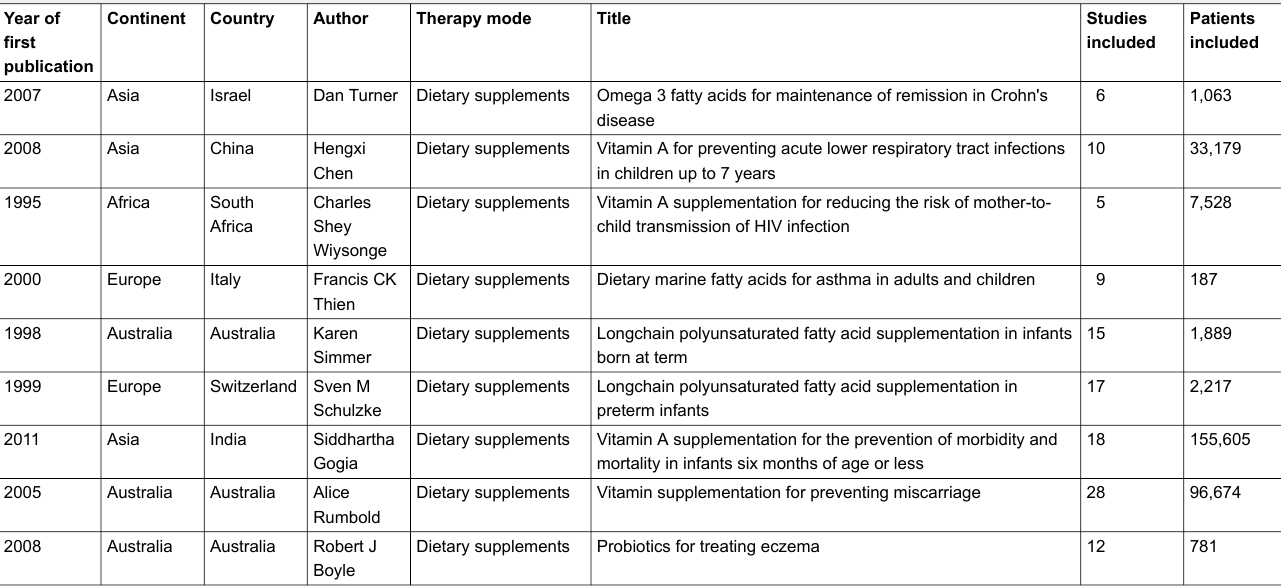
Table 2: Characteristics of included reviews with a “negative” recommendation